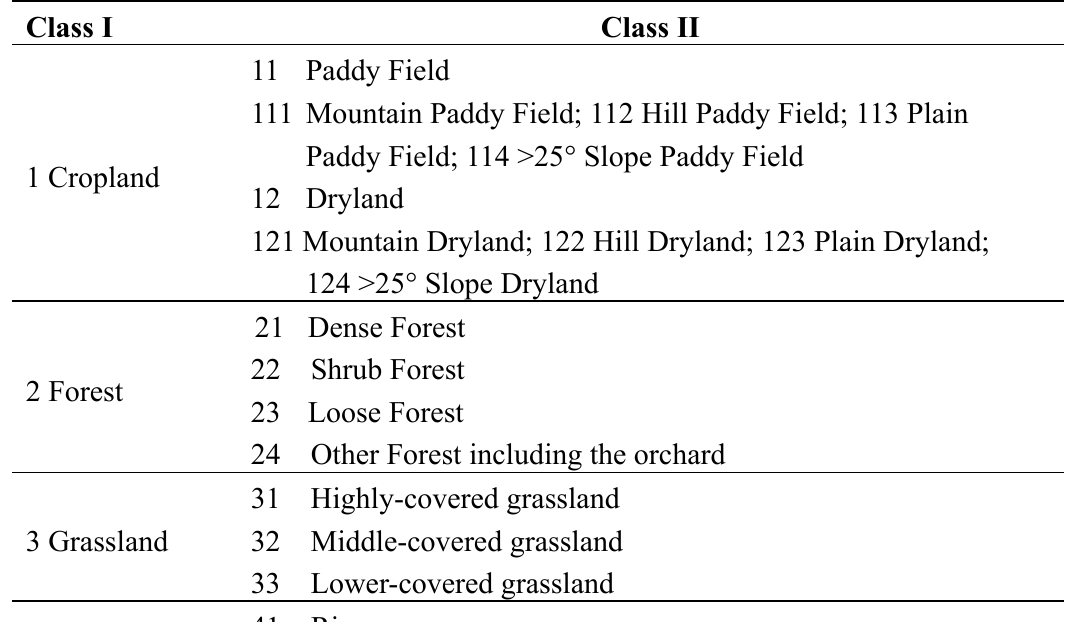
Table 1. Land Use Classification System and